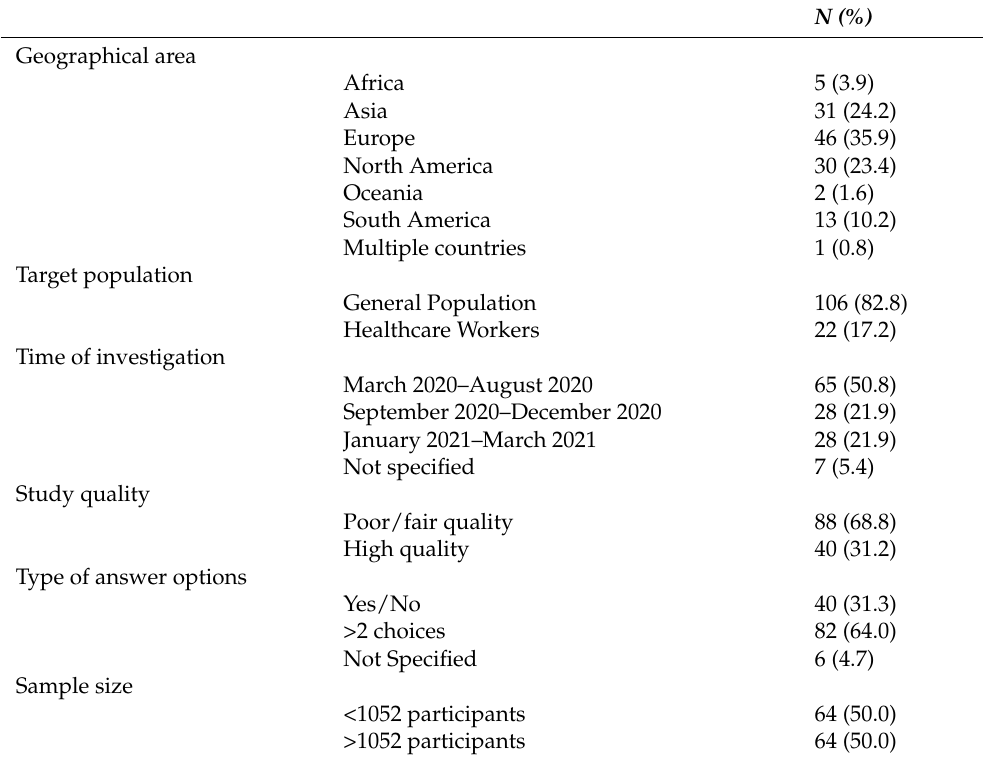
Table 1. Characteristics of the prevalence estimates included in the proportion meta-analysis of COVID-19 vaccination acceptance.